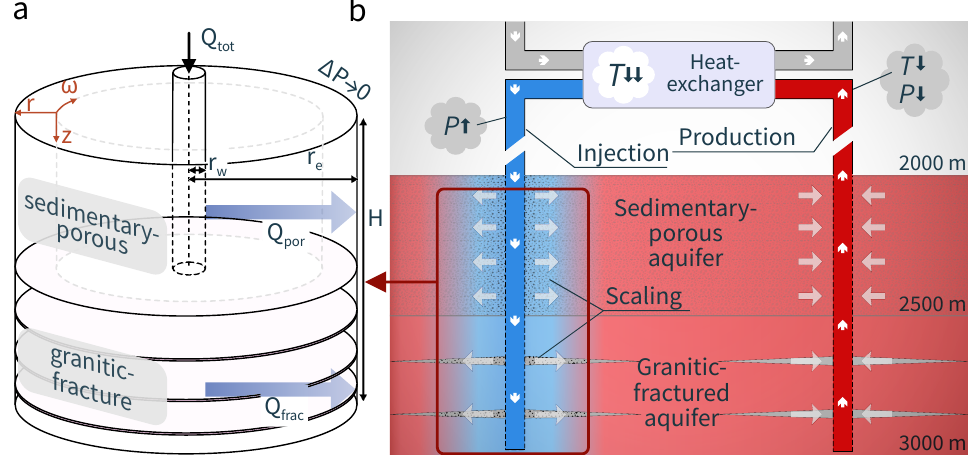
Figure 1. Conceptual model of radially diverging groundwater flow near an injection well of a geothermal system. ( a ) Injection flow components are split into two parts for the sedimentary–porous aquifer (upper layer) and the granitic–fractured aquifer with variable sizes and different amounts of horizontal fractures (lower layer). The boundary is the range of influence, i.e., where the induced pressure difference moves towards zero. ( b ) Produced fluids, originating from the deep reservoir, are cooled and depressurised along the flow path through the heat exchanger. Thermodynamically disequilibrated fluids are then re-injected via the injection well, where scaling and formation damage are